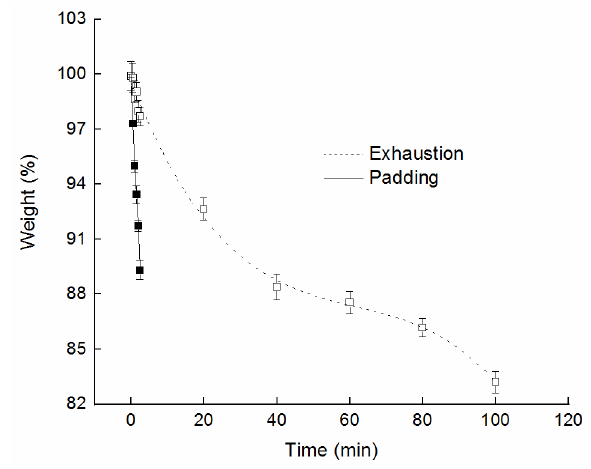
Figure 6. Effects of different processes on weight loss.